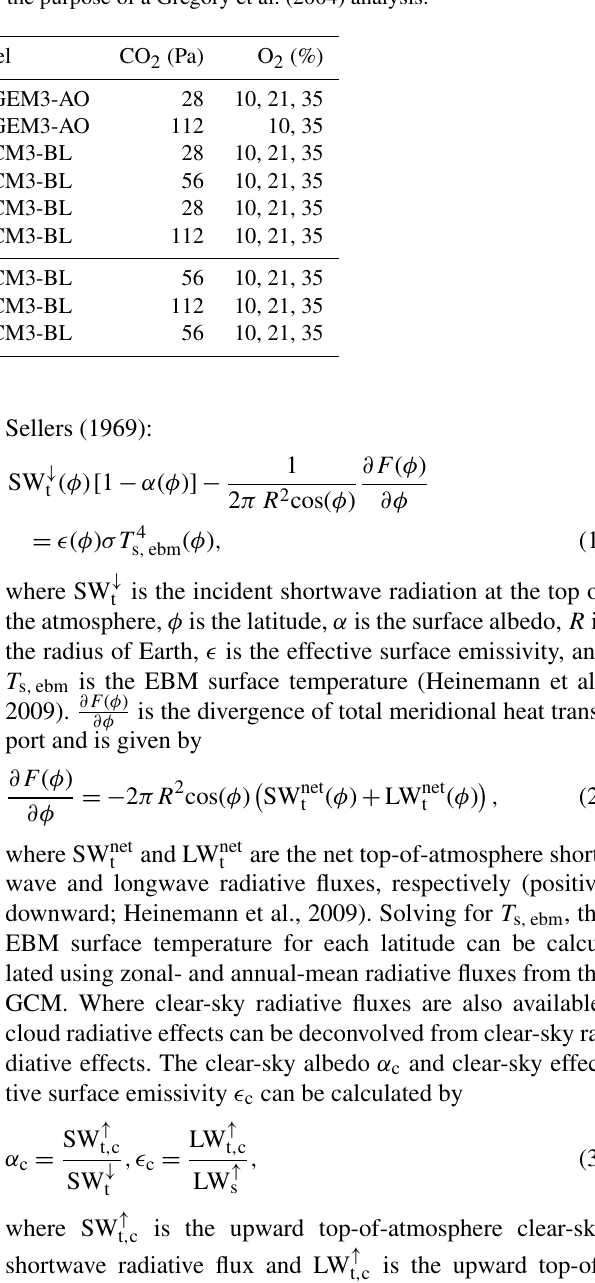
Table 1. Summary of experiments. Experiment names AA-BBB include the continental configuration (AA) and model used (BBB). Exper- iment names N × AA-BBB indicate a multiplier of CO 2 with respect to AA-BBB. A star ( ∗ ) indicates that the CO 2 multiplier was applied instantaneously and the transient adjustment to climate was analysed for the purpose of a Gregory et al. (2004)